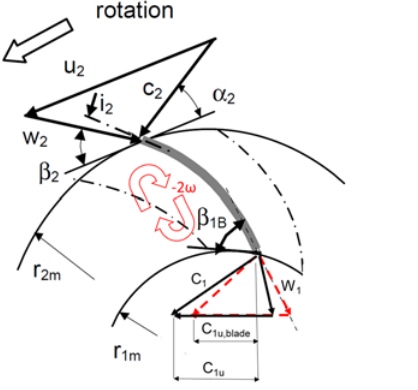
Figure 4. Velocity triangles at the inlet (2) and at the outlet of the runner (1). At the outlet both actual (solid line) and blade congruent (dashed line) velocity triangles are